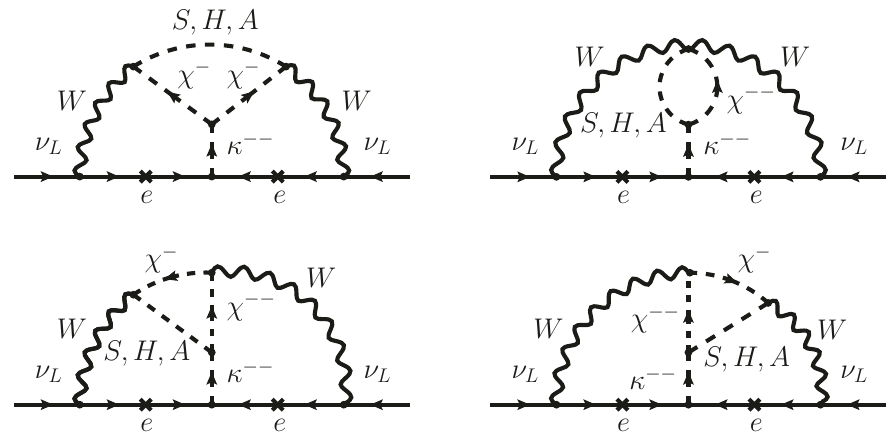
Figure 7 . Three loop diagrams contributing to neutrino masses in the unitary